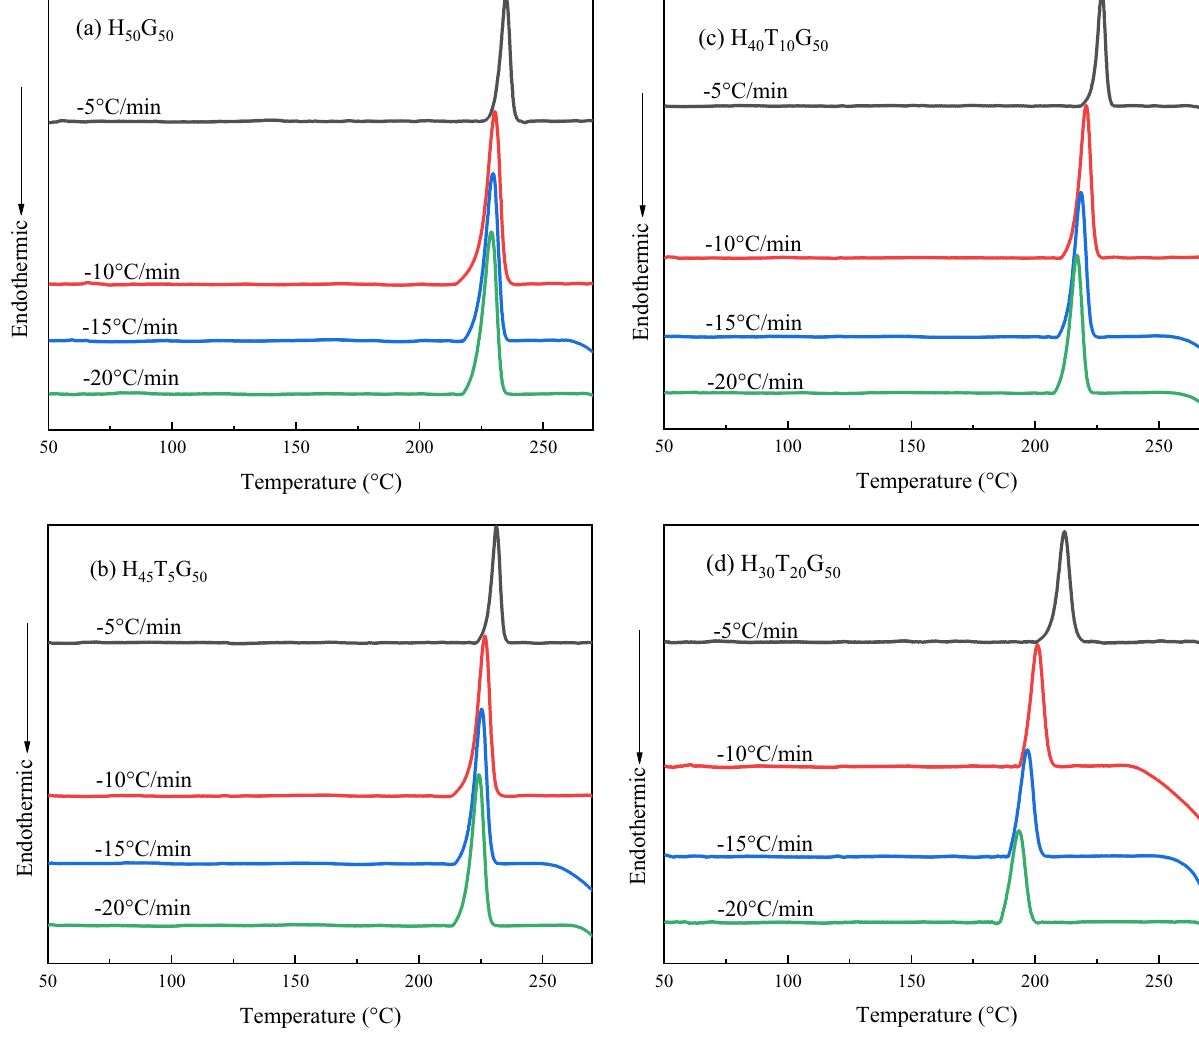
Figure 2: DSC curves of the cooling scans at rates of − 5, − 10, − 15, and − 20°C · min − 1 for H 50 G 50 ( a ) , H 45 T 5 G 50 ( b ) , H 40 T 10 G 50 ( c ) , and H 30 T 20 G 50 ( d ) ,